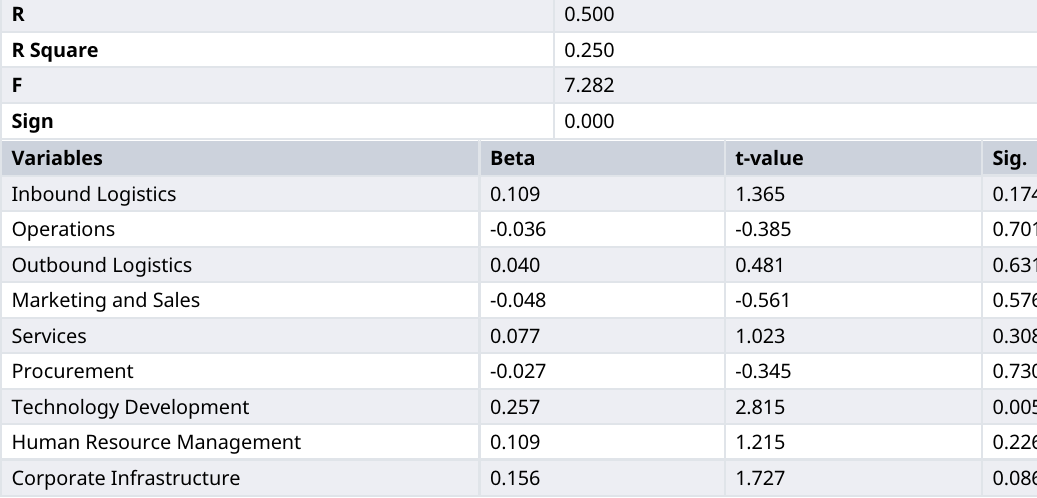
Table 3. Multiple linear regression analysis for effect of green value chain activities on firm performance. R 0.500 R Square